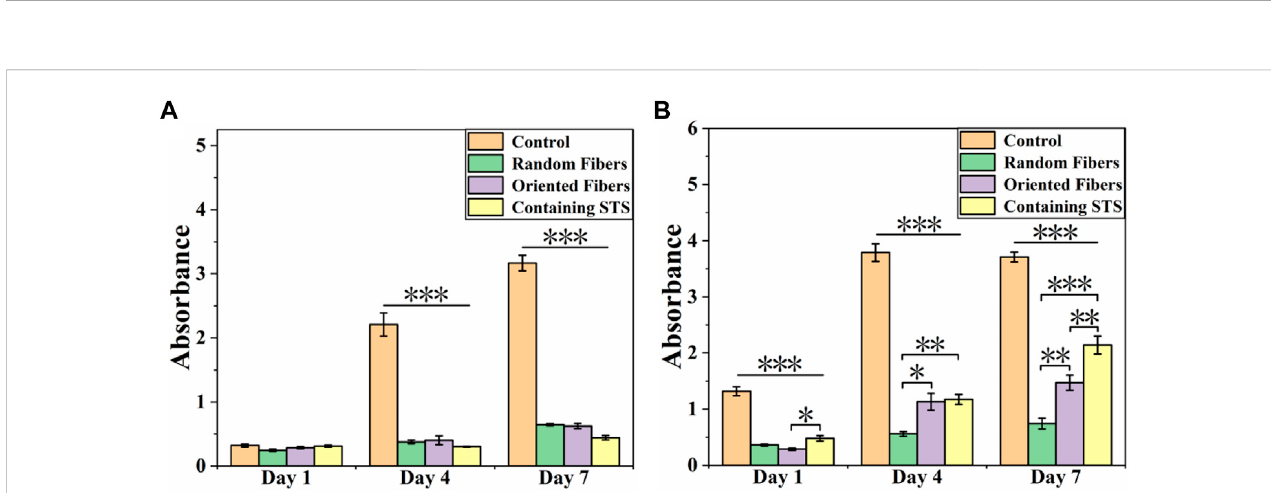
FIGURE 7 Cell compatibility of (A) Raw264.7 and (B) HUASMCs on random- fi ber membranes, oriented- fi ber membranes, and oriented- fi ber membranes containingSTS (N=3).***abovethehorizontallineindicatesasigni fi cantdifferencebetween thecontrol groupandalltheothergroups,and p < .001.***,**, and * above the parentheses indicate signi fi cant differences between the two groups under the parenthesis line, and *** p < .001, ** p < .01, and ** p <